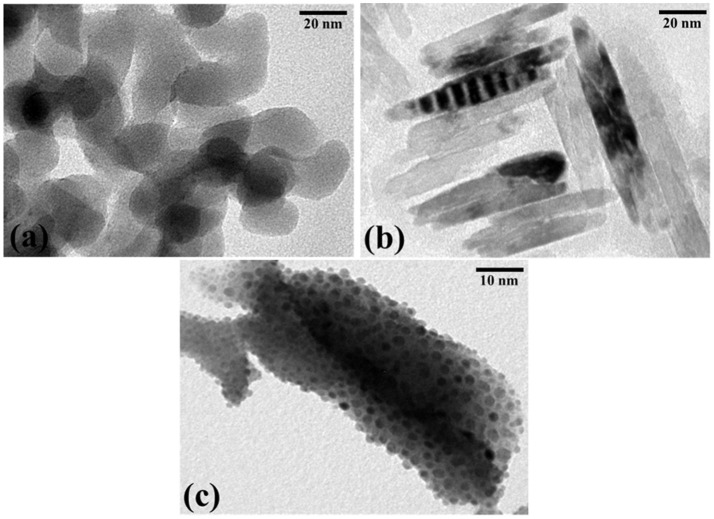
TEM images of (a) SiO2, (b) BiVO4, and (c) SiO2-coated BiVO4.